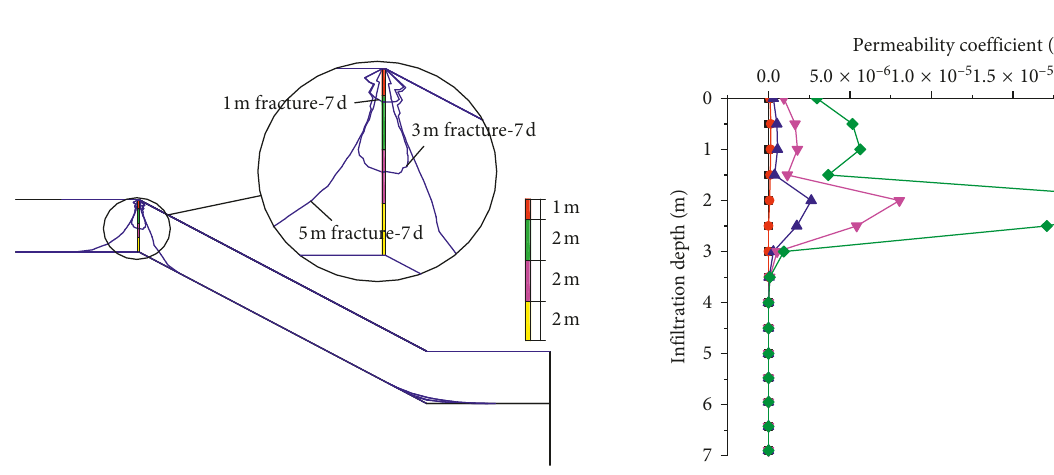
different fracture depths ( x � 15m).